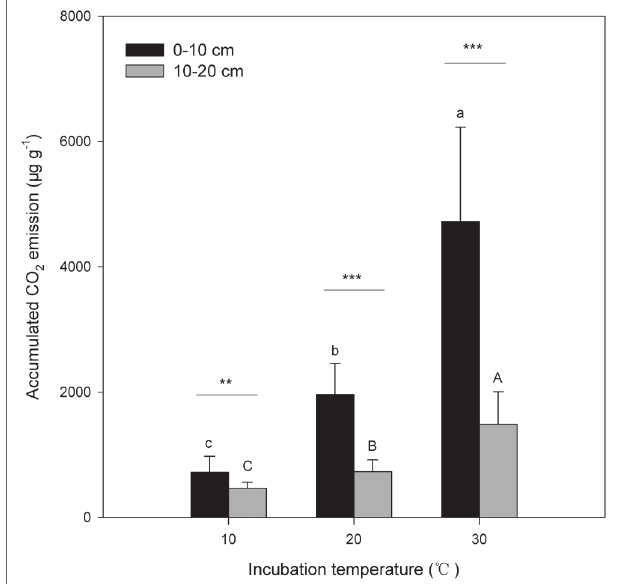
FIGURE 1 | Accumulated amount of CO 2 emissions from surface (0–10 cm) and subsurface (10–20 cm) soils within the investigation period. The bars are the average values, and the error bars are the standard deviations ( n = 4). Different lowercase letters above the bars indicate significant differences among the temperature treatments for surface soil, while uppercase letters indicate significance for subsurface soil. Double and triple stars indicate significant differences between soils under each of the incubation temperatures at significance levels of p < 0.01 or p < 0.001,